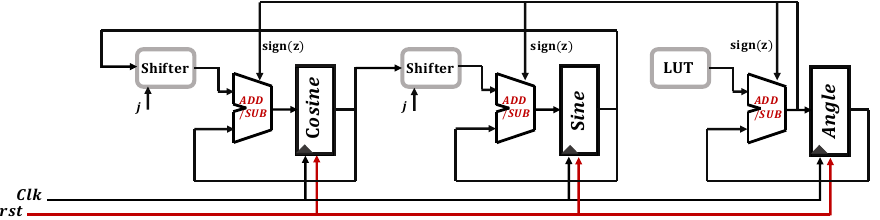
Figure 5. Architecture of the CORIDC